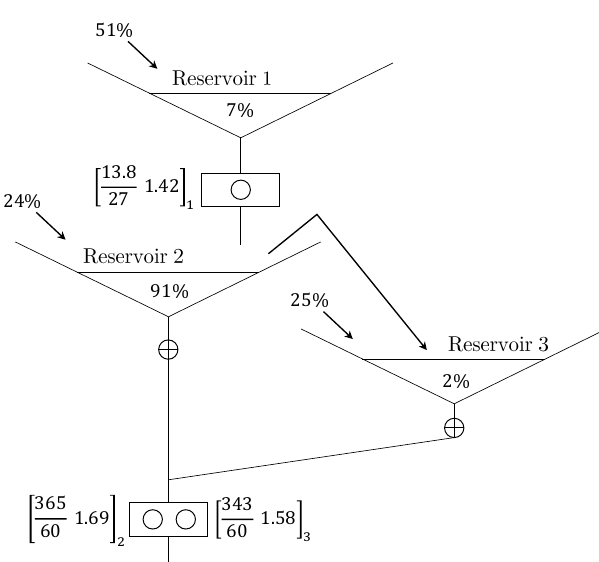
Figure 5. Illustration of the hydropower system. There are three reservoirs, each represented by its relative storage capacity and inflow compared to the system as a whole. As an example, Reservoir 1 has 7% of the system’s storage capacity and 51% of the inflow. Reservoirs 2 and 3 have a hatch downstream that controls which reservoir is depleted. Only one of the reservoirs can be depleted at a time, due to their different head. Reservoir 2 can also bypass water, indicated by the arrow between the reservoirs. The hydropower stations are represented by their maximum power at nominal head, discharge and the energy equivalent ( MW MWh/m 3 ). Since the lower power station is connected to two reservoirs, it has m 3 /s different efficiencies, depending on which reservoir is